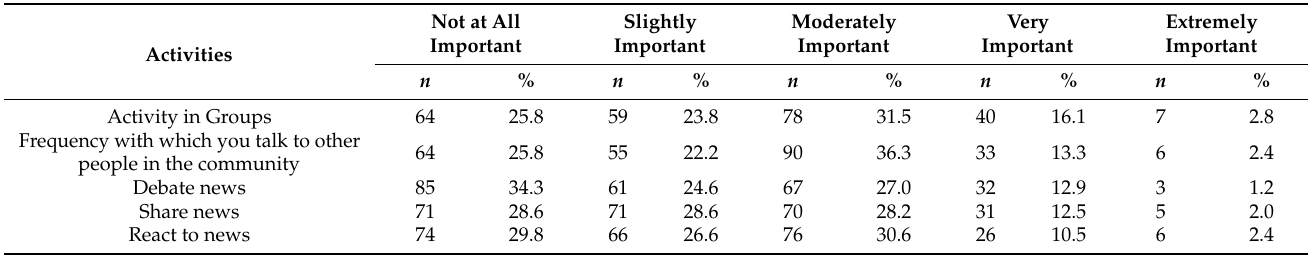
Table 2. Main activities respondents like to be valued for ( n =